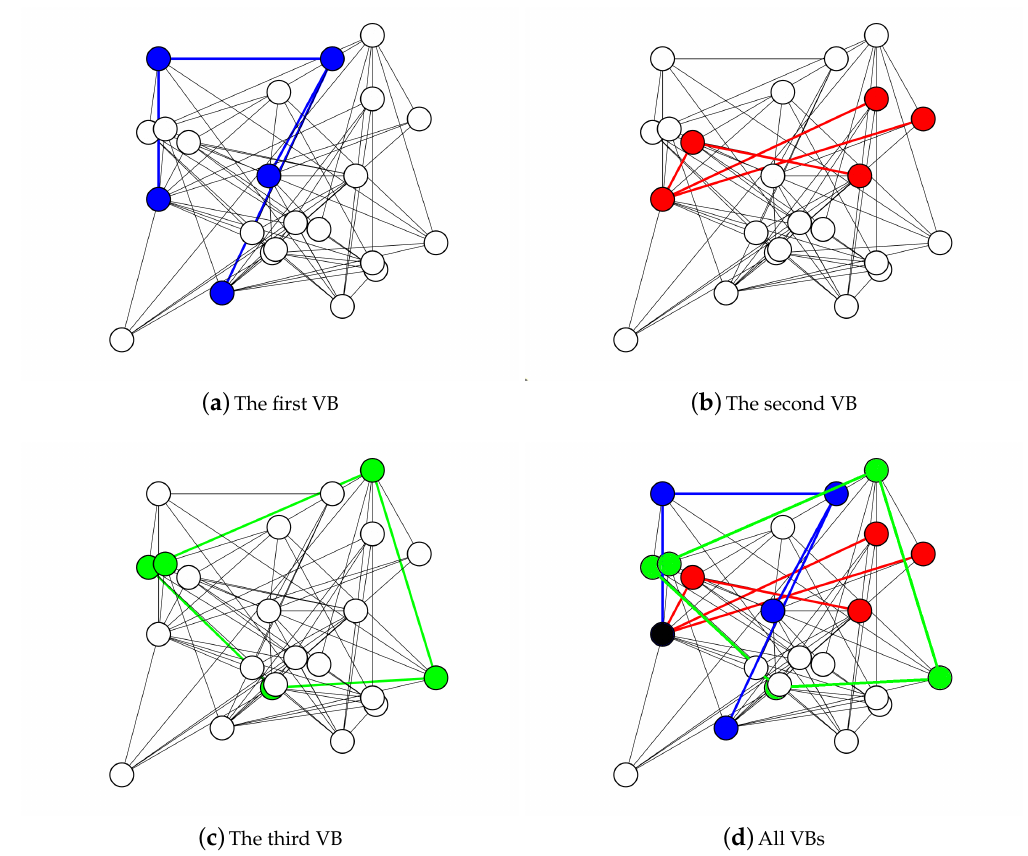
Figure 16. N 2 with three virtual backbones.